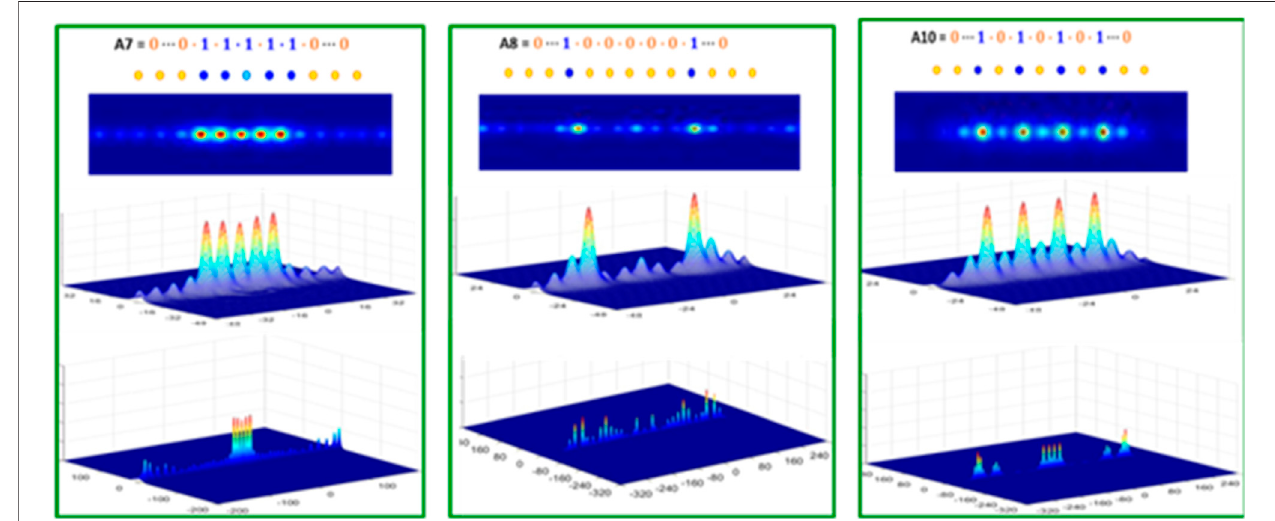
FIGURE 6 | Center of distributions of BPL s A 7 (left panel) , A 8 (central panel) and A 10 (right panel) resemble binaries 7, 8, and 10, respectively. See the text above for more details.